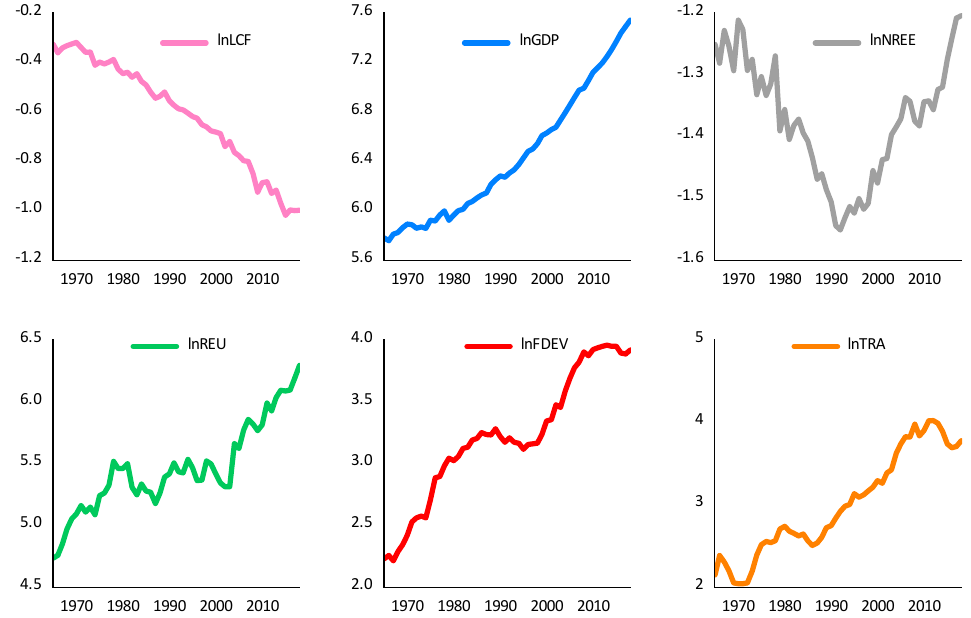
Figure 1. Time series plots of the logarithmic LCF, GDP, nonrenewable energy efficiency, renewable energy utilization, financial development, and trade openness from 1965 to 2018.